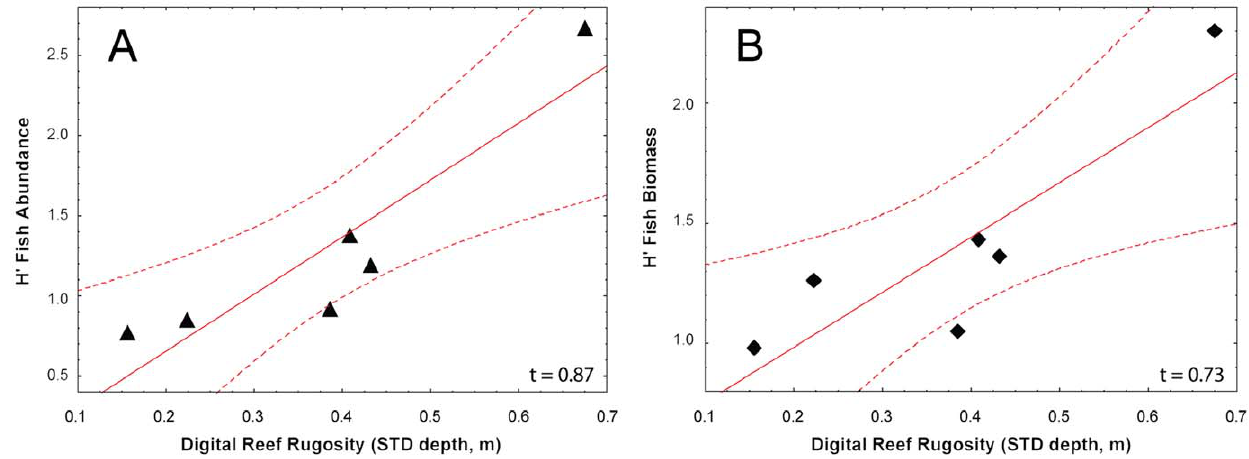
Figure 6. Fish biodiversity diversity correlated with reef structural complexity. Fish biodiversity based on the abundance of fish (A) or the calculated biomass of each species (B) is significantly correlated with DRR std (Kendall tau t =0.87 and 0.73 respectively, p , .05 for both. The dashed lines delimit 95% confidence limits).